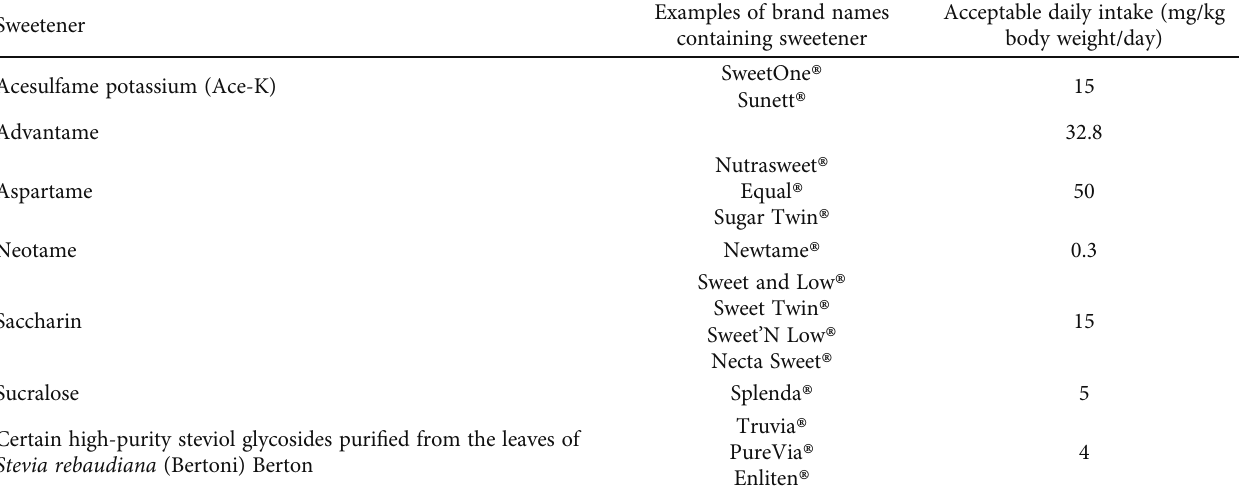
Table 6: Sugar substitutes, acceptable daily intake: adapted after [48].